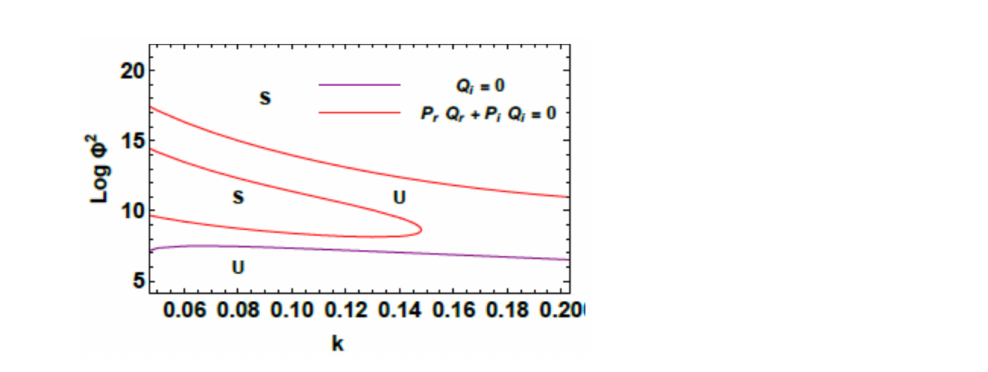
Figure 15. Variation of Log Φ 2 with k to depict the contribution of Equations (53) and (54) along with data A.